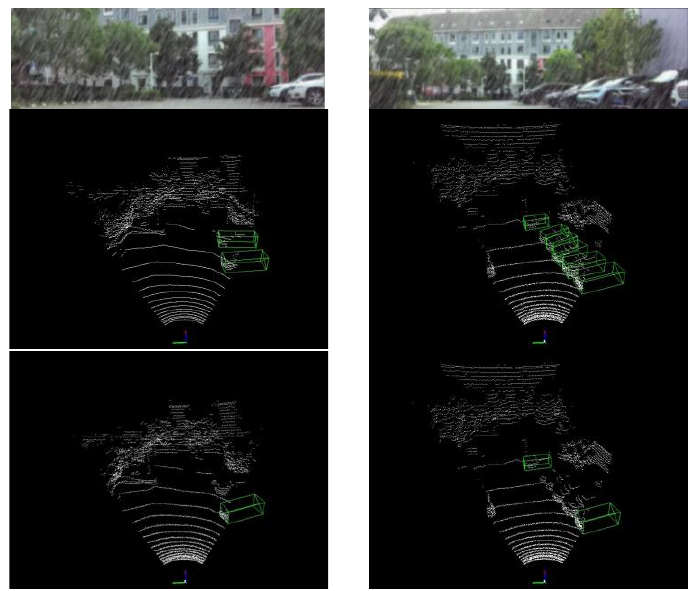
Figure 9. V isual results of physical test platform dataset. Figure 9. Visual results of physical test platform dataset.